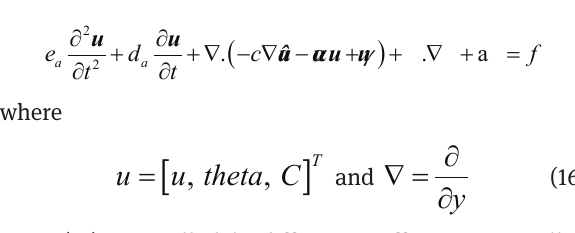
this range, the heat transfer also is less than that at other